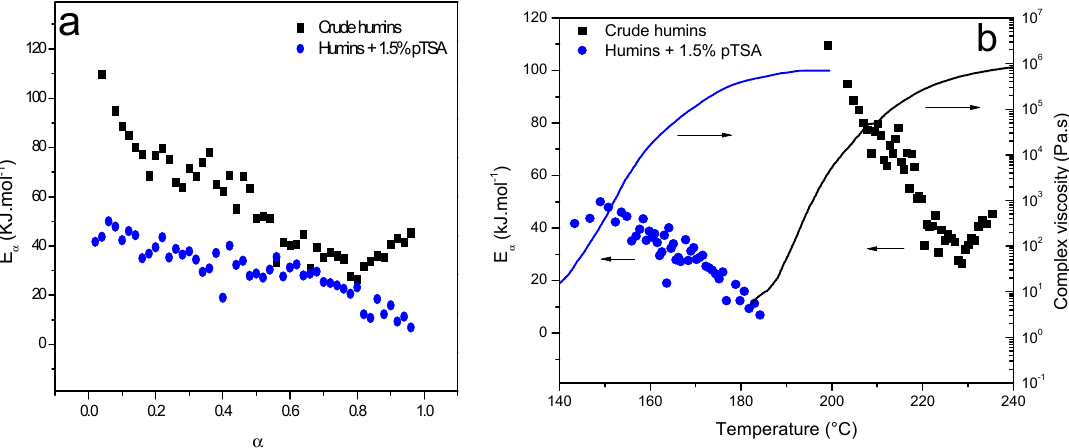
Figure 6. Evolution of the e ff ective activation energy ( E α ) as function of ( a ) the extent of conversion ( α ) and ( b ) the temperature, evaluated from non-isothermal data for crude humins (black squares) and Humins / pTSA (blue circles) and ( b ) complex viscosity and e ff ective activation energy ( E α ) variation with temperature.